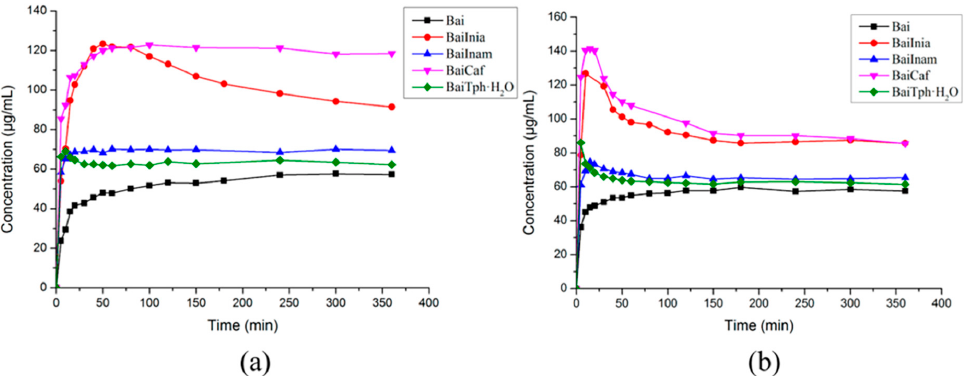
Figure 8. Powder dissolution profiles of Bai and its four cocrystals (BaiInia (baicalein–isoniazide), BaiInam (baicalein–isonicotinamide), BaiCaf (baicalein–caffeine) and BaiTph · H 2 O (baicalein–theophylline monohydrate)) in ( a ) pH 2.0 and ( b ) pH 4.5 buffer solutions. Adapted from [69] with permission. Copyright © 2017 American Chemical Society.